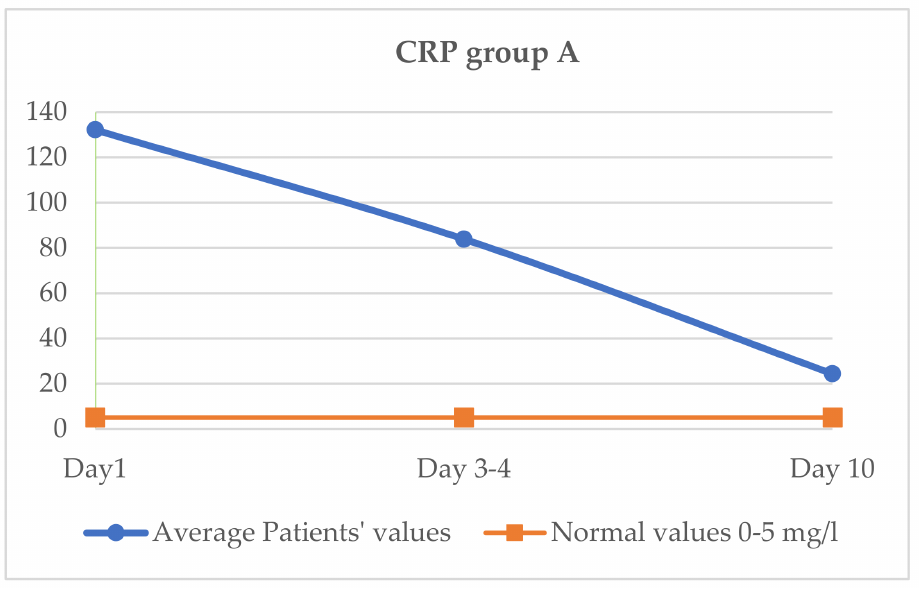
Figure 1. Variation CRP group